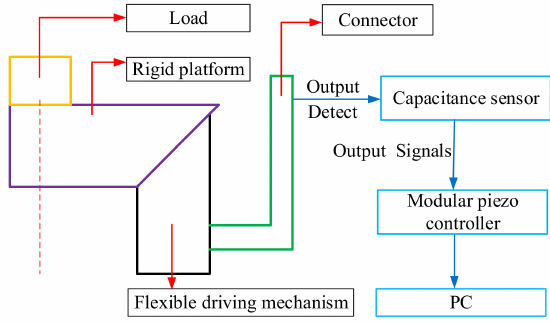
Figure 16. Test method of bearing performance.